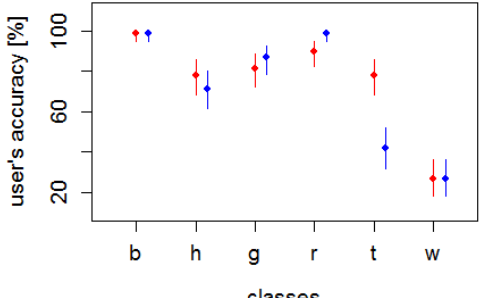
Figure 5. User’s accuracy with confidence intervals for two methods of classification (Red=DT, blue=SVM, n c =91). Abbreviations of classes are explained in Table 2.